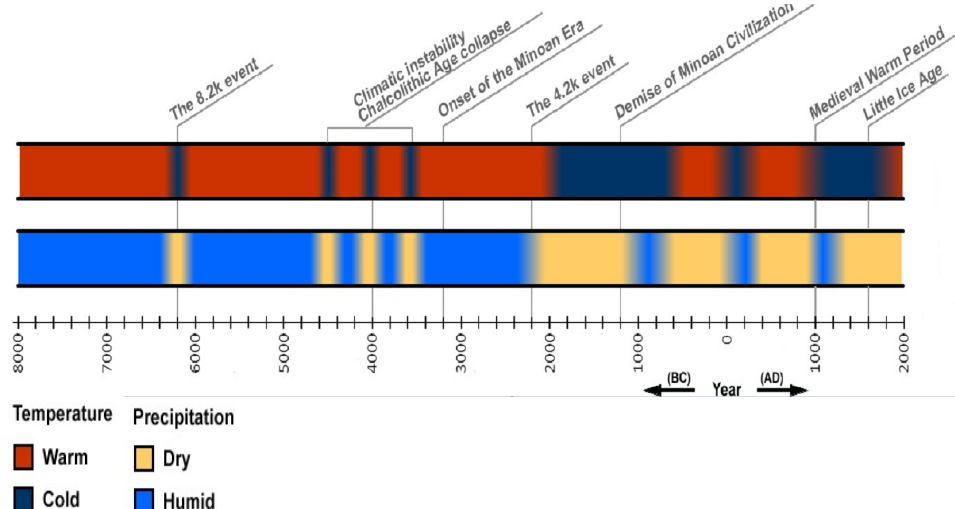
Figure 4. Climate reconstruction of Crete for the last 10,000 years based on proxy and historical data (with permission of [32] ).